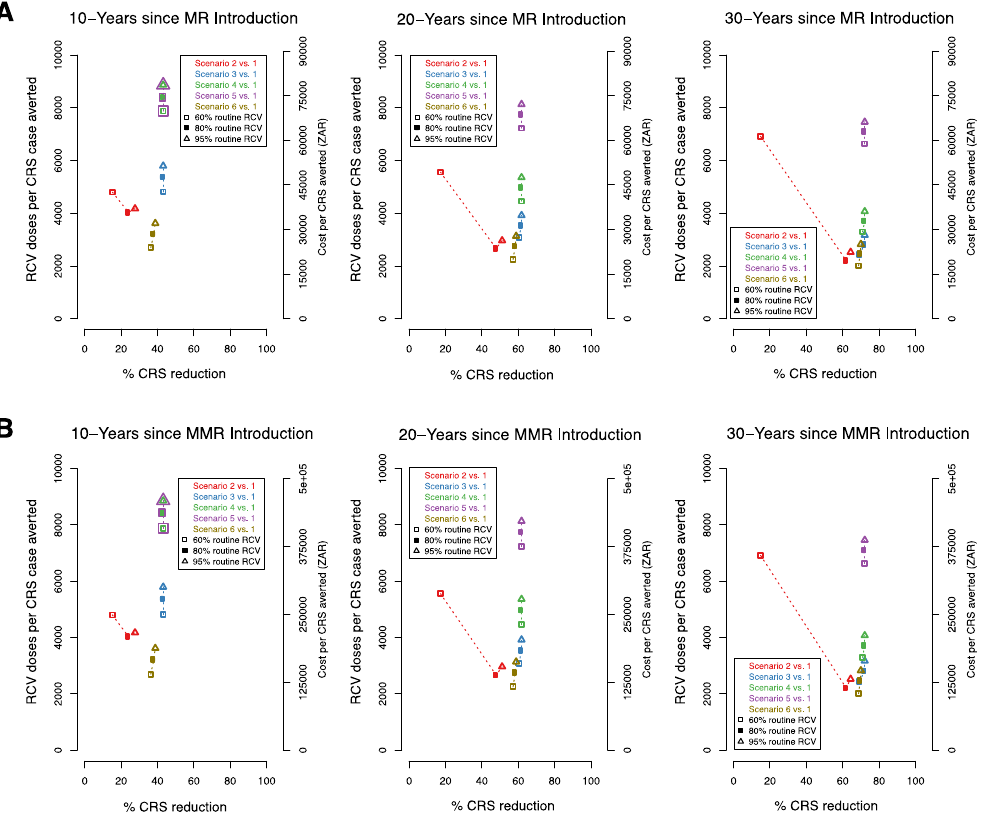
Figure 4. The percent reduction in CRS cases by the number of RCV doses (left y-axis) and cost (right y-axis) per CRS cases averted over three time horizons (10, 20, 30 year). Each figure compares the percent reduction in CRS cases for scenarios 2–6 to scenario 1 (represented by colours) for three RCV coverages (60%, 80%, 95% represented by shapes). Cost is evaluated based on the measles-rubella (MR) ( A ) and measles-mumps-rubella (MMR) ( B ) vaccine. At the 10 year horizon in both 4A and 4B, the numbers corresponding the scenario 4 and 5 overlap and have been represented as overlapping points.